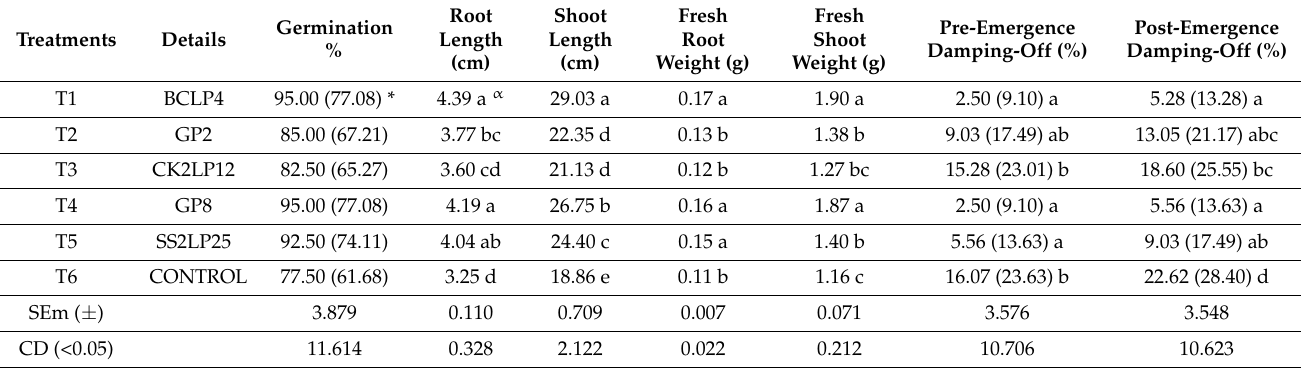
Figure 5. Enhancement of shoot length (a) and root length (b) of cowpea plants after treatment with selected lateritic Pseudomonads. Table 10. Impact of native lateritic Pseudomonads on cowpea plants in terms of germination, plant growth and disease